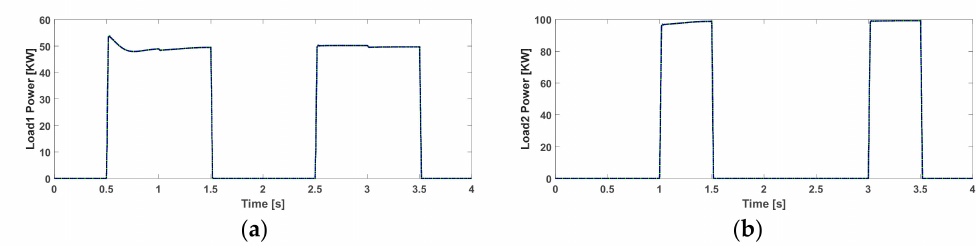
Figure 12. Loads power consumptions during fault-free operation: ( a ) Load 1, and ( b )